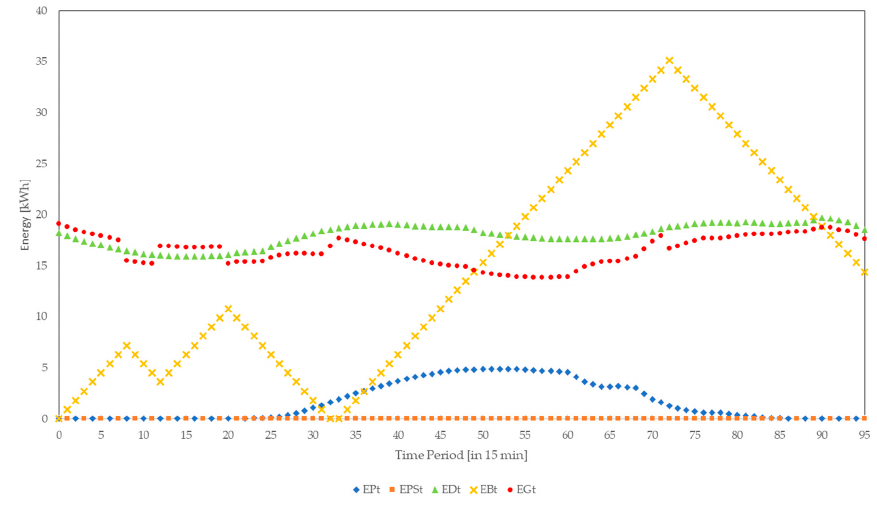
Figure 8. Graphic analysis of the effects of an integrity attack on grid energy price.